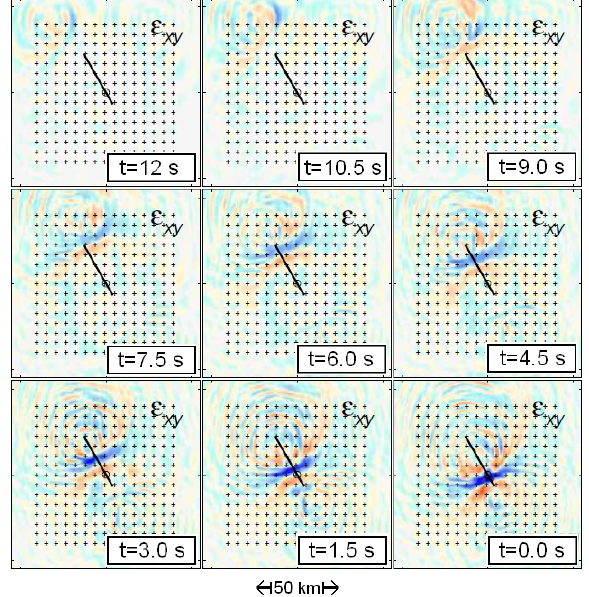
Fig. 8. Snapshots of the time-reversed strain component (cid:15) xy at 12.5km depth for the dense array of 225 regularly spaced receivers. The fault trace is indicated by the black line. All snapshots are shown in the same amplitude